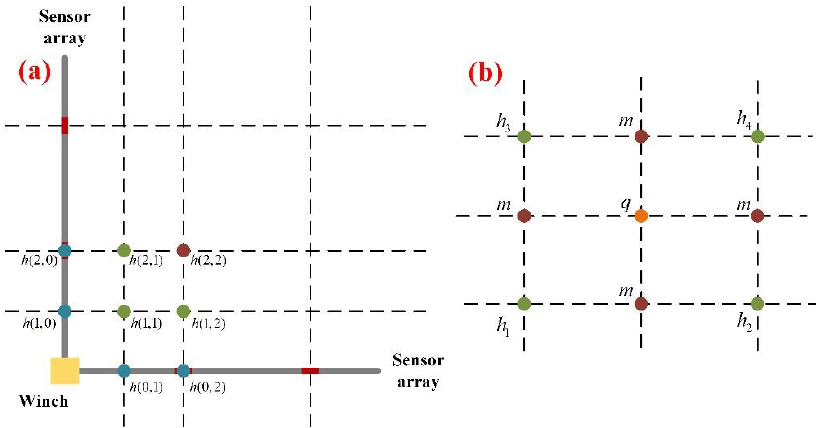
Figure 11. ( a ) Neighborhood interpolation; ( b ) Subdivision.